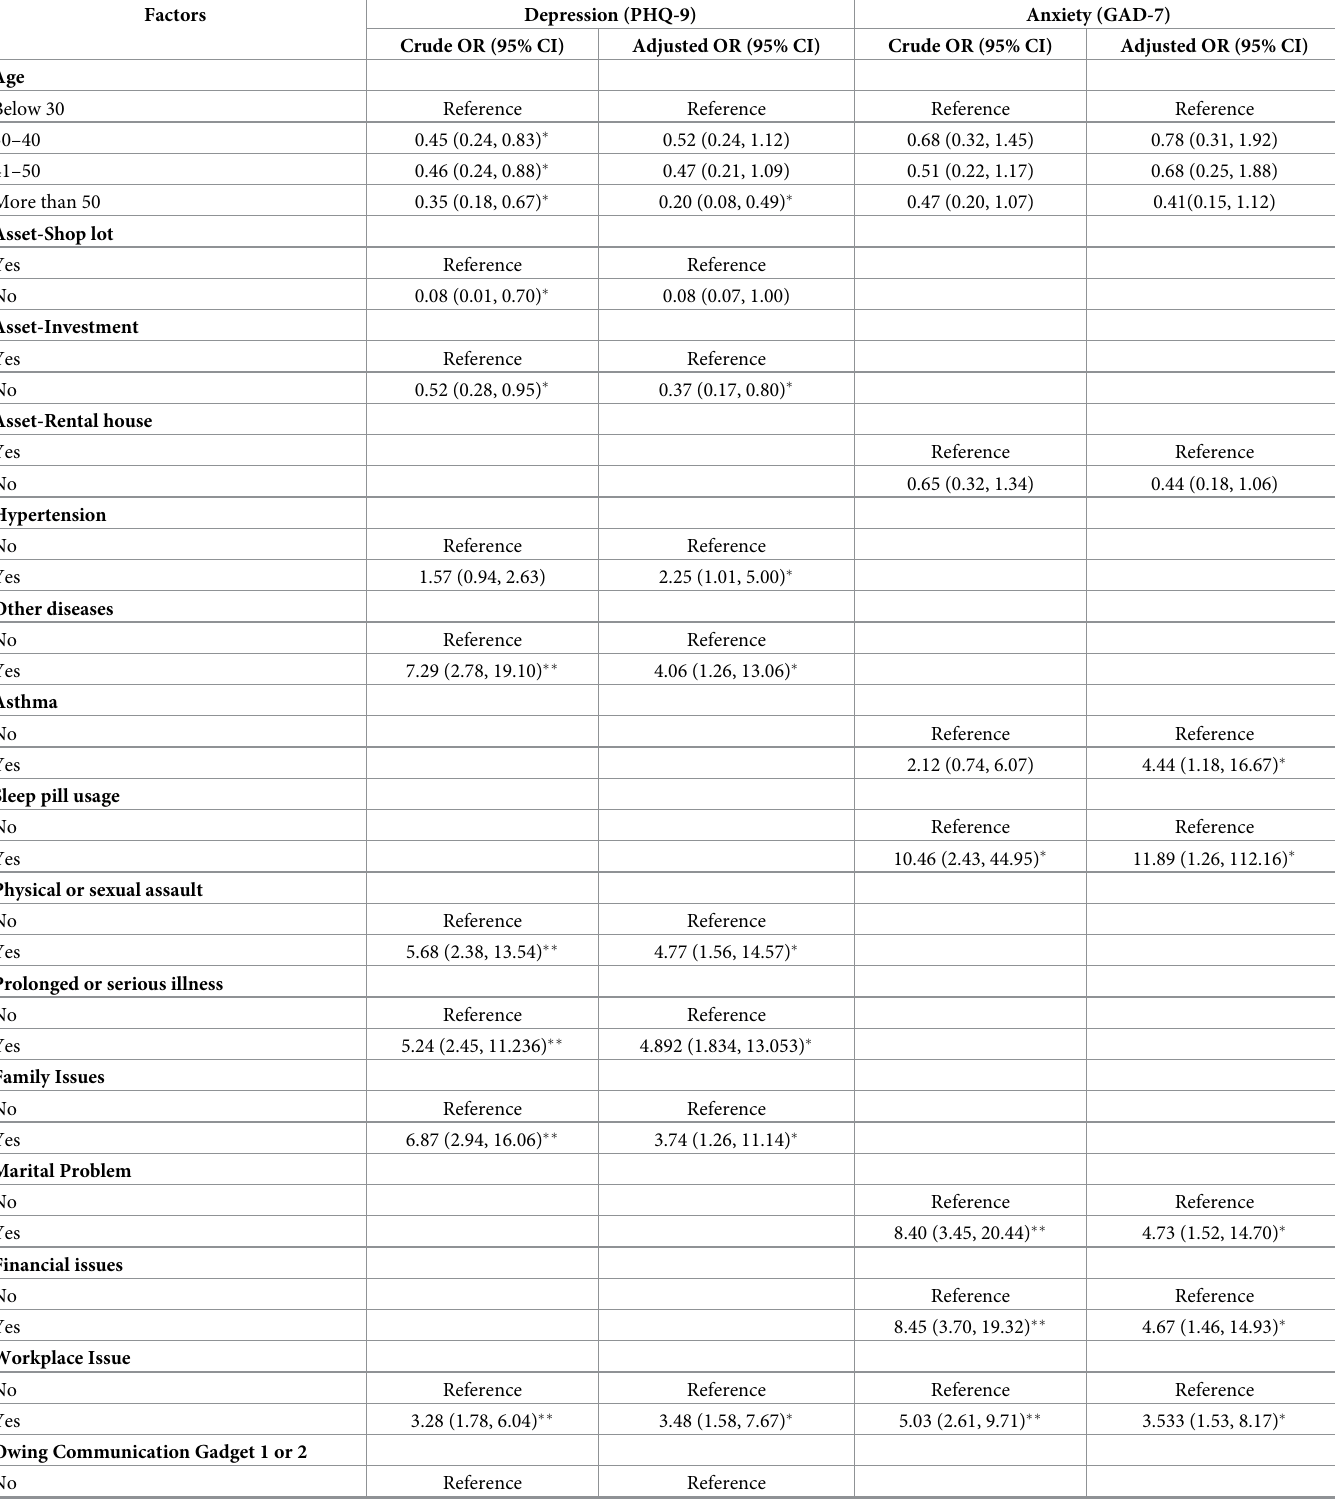
Table 2. Simple and multivariable logistic regression on factors associated with depression (n = 385) and anxiety symptoms (n = 398) (cut-off at